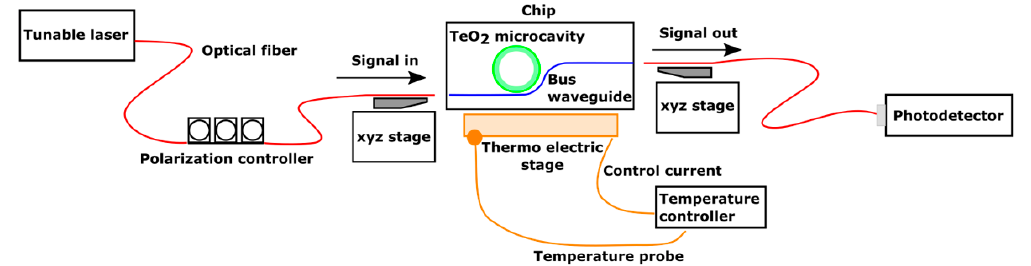
Figure 2. Diagram of the optical setup used to characterize the devices.